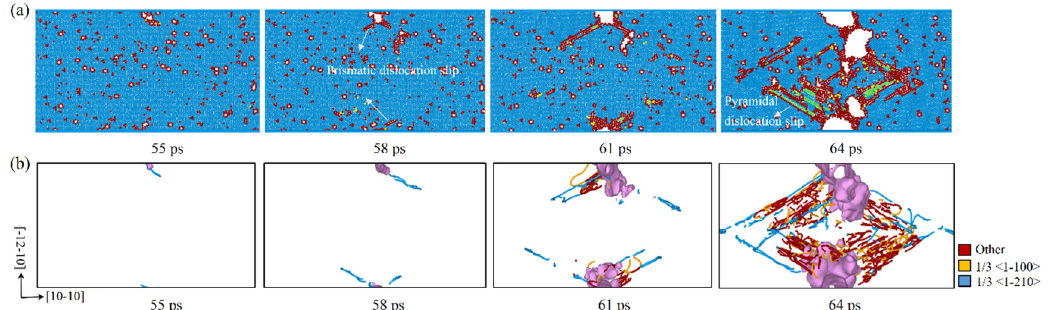
Figure 7. Void evolution of the sample with C v = 0.5% at different time points during initial spallation loading along the [10 – 10] direction. ( a ) Atomic configurations of a chosen section of the spall region. loading along the [10–10] direction. ( a ) Atomic configurations of a chosen section of the spall ( b ) Mechanism of void growth based on dislocation emission is analyzed using DXA: 1/3 <1 – 100>